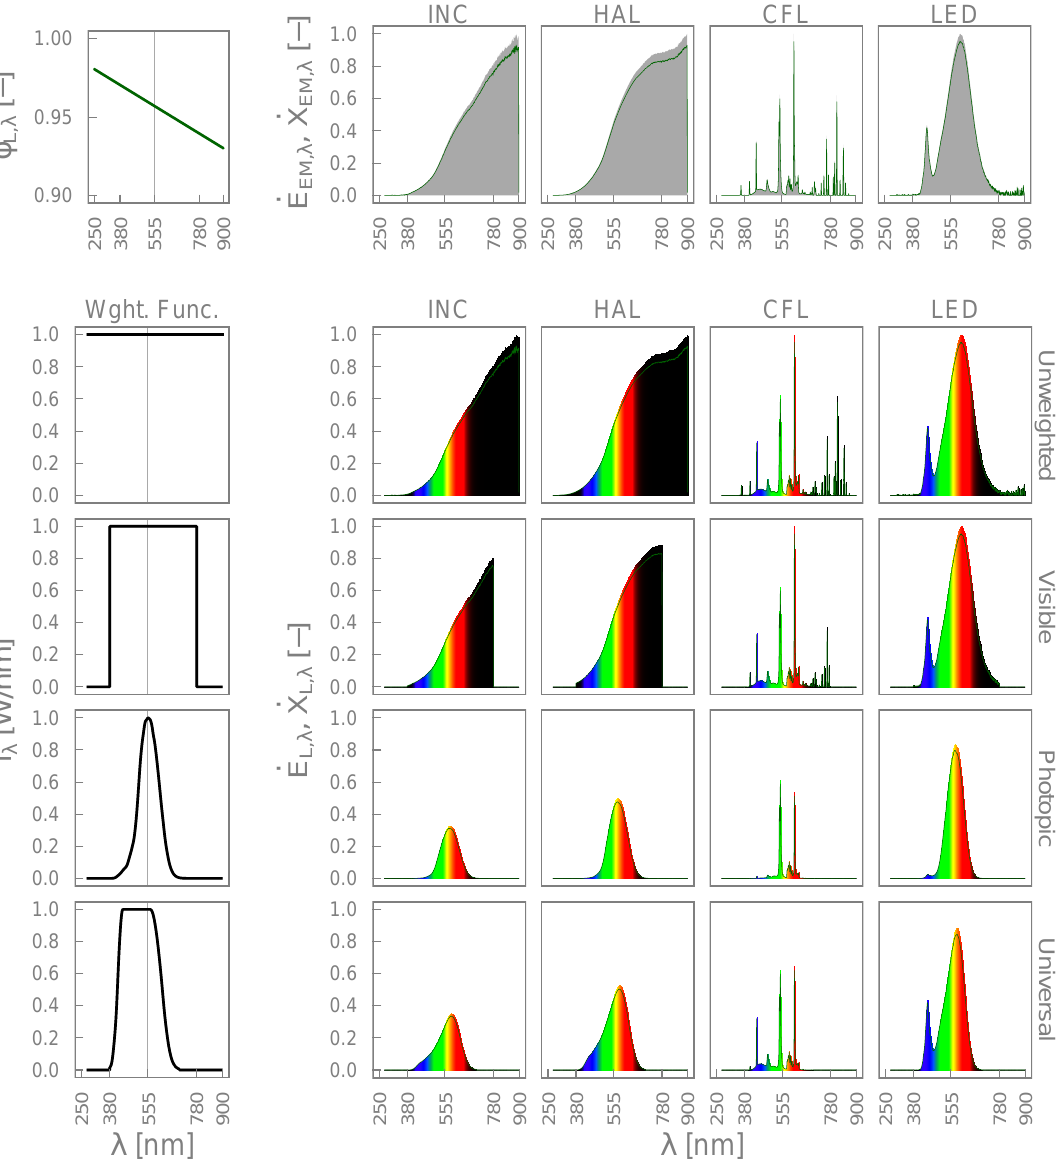
Figure 5. Upper left : The spectral exergy-to-energy ratio of light ( φ L , λ ) from Equation (33). Top : Gray regions indicate spectral radiant power ( ˙ E EM , λ ) for lamps in Table 3. Dark green lines show spectral exergy ( ˙ X EM , λ ). Left : Spectral weighting functions ( f λ ), as shown in Table 2. Lower right : Rainbow-colored regions indicate the human perception of color and the portion of light deemed valuable for human perception. The tops of the rainbow regions give spectral light as energy ( ˙ E L , λ ). The dark green lines show spectral light as exergy ( ˙ X L , λ ). The spectral luminous power ( Φ λ , pl ) is shown in the “Photopic” row. Peak spectral radiant power ( ˙ E EM , λ ) values are normalized to 1 for each